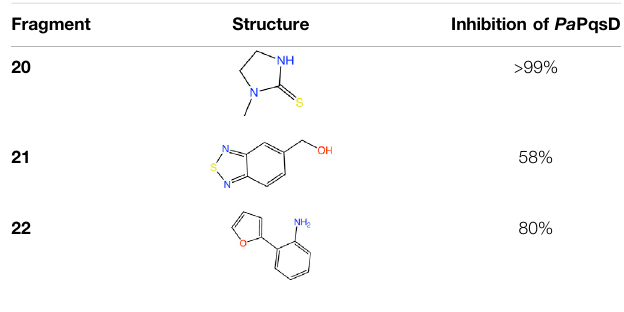
Frontiers in Molecular Biosciences |